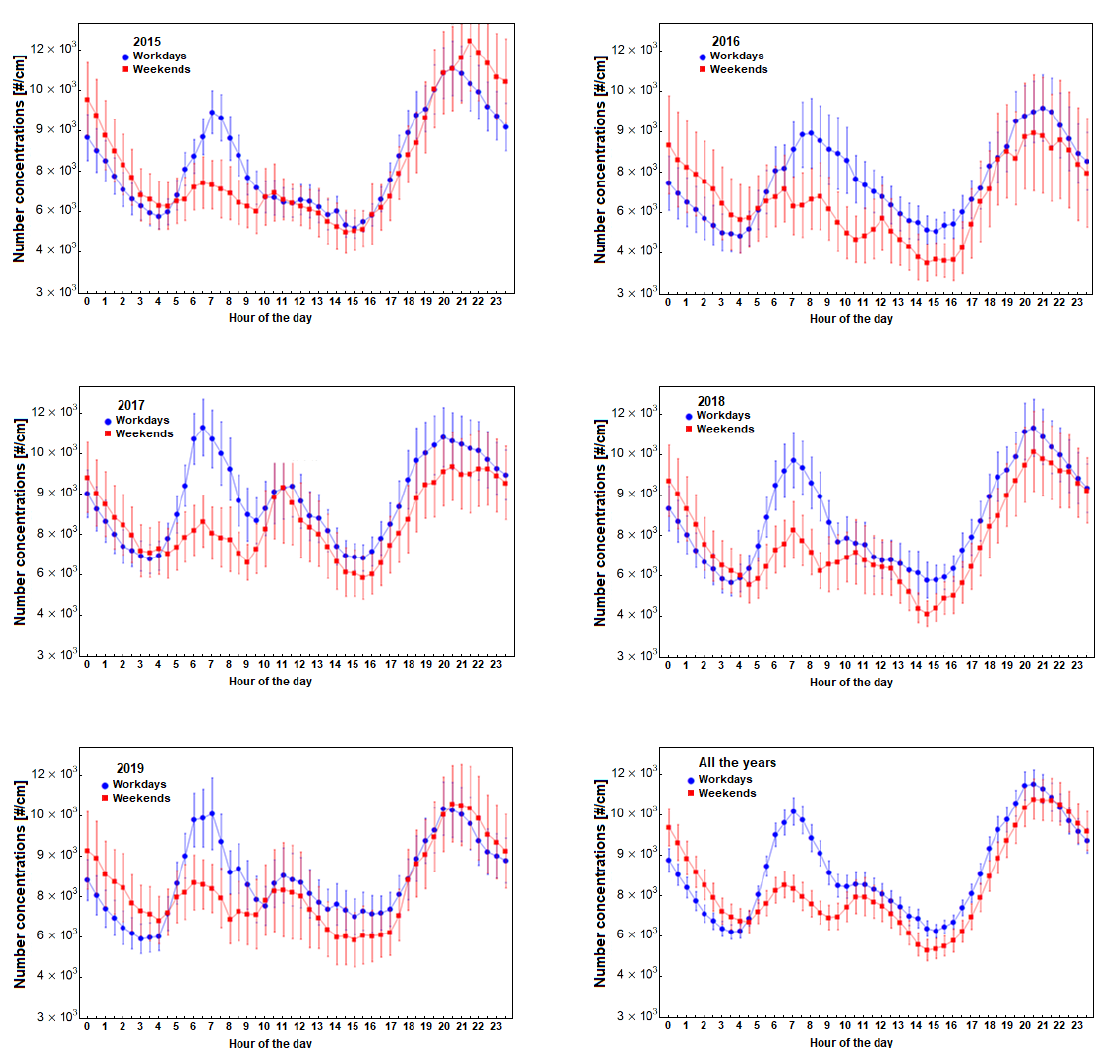
Figure 5. Temporal evolution of particle number concentrations, averaged on workdays (blue dots) and weekends (red dots), separately for each year and the whole measurement period. Vertical bars represent standard errors.